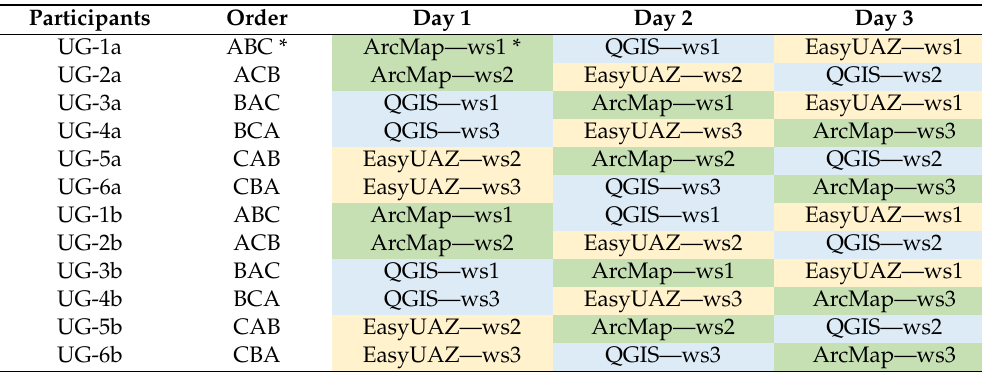
Table 1. The counter-balanced order adopted by participants to prepare UAZ with ArcMap, QGIS and